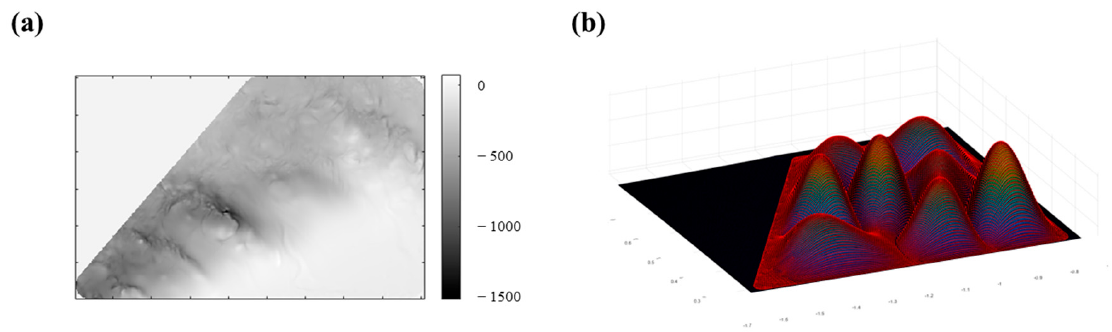
Figure 23. Regenerated ( a ) surface pressure (unit: Pa); ( b ) mode shape of left window.